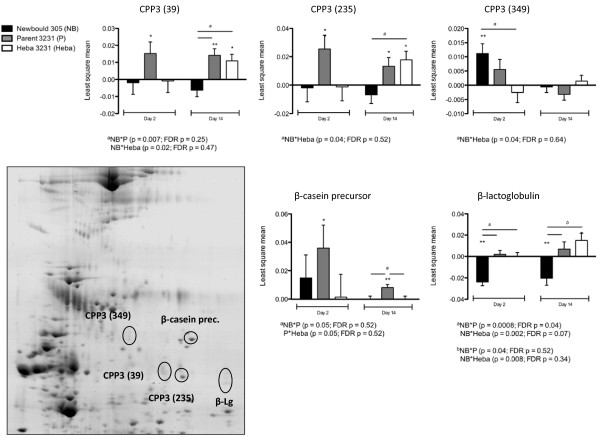
Two-dimensional gel electrophoresis of milk proteins. Proteins were resolved on a 13 cm Immobiline DryStrip, pH 3-10, followed by 12.5% SDS-PAGE. Circled spots are significantly different in protein expression between treatment groups as well as on day 2 or 14 pi, relative to day 0 values. Corresponding graphs detail the least square mean of the log transformed spot intensities ± SEM for each spot. Significant changes in protein expression levels relative to baseline (day 0) are denoted by asterisks (P < 0.05* and P < 0.01**). a,b significant differences in protein expression between treatment groups on day 2 or 14 pi with raw p-values and FDR-adjusted p-values presented (P < 0.05).